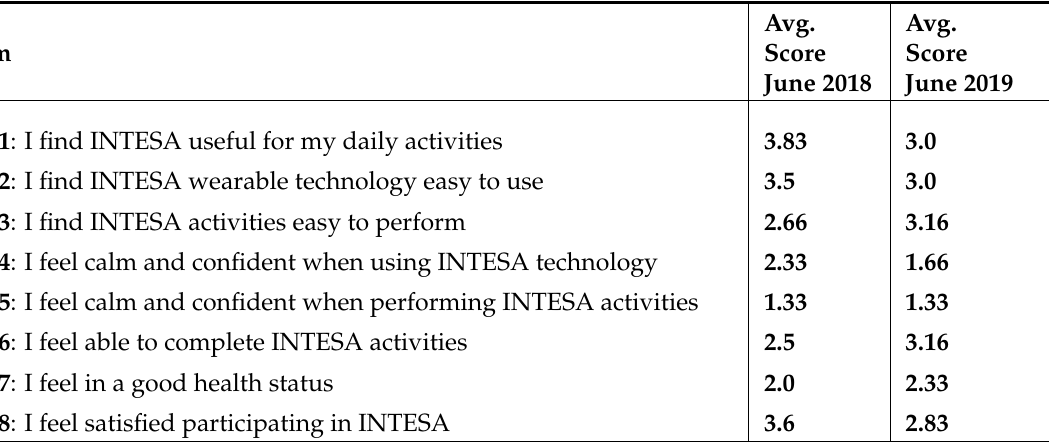
Table 5. User acceptance (primary